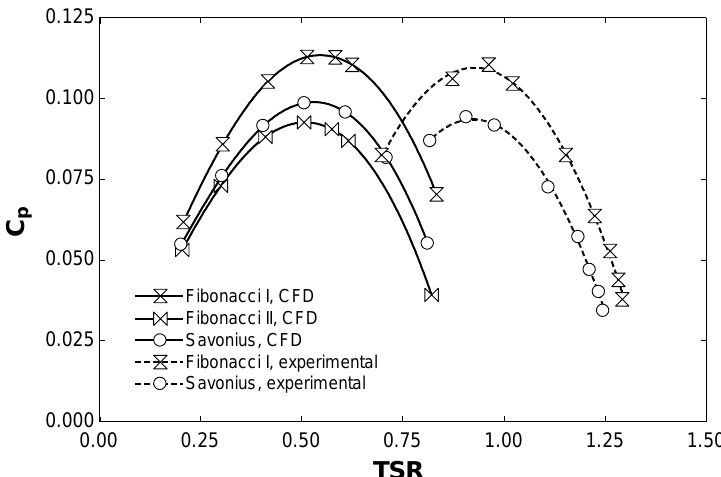
Figure 7. Power coefficients against TSR for Fibonacci I, Fibonacci II, and Savonius configurations.